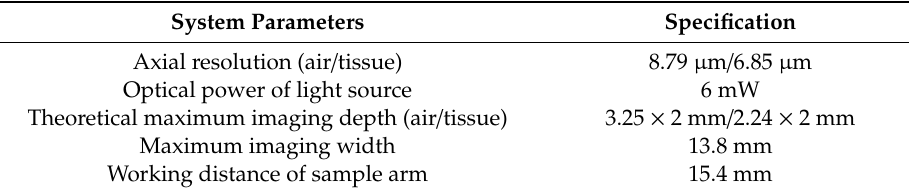
Table 1. The parameters of the SD-OCT